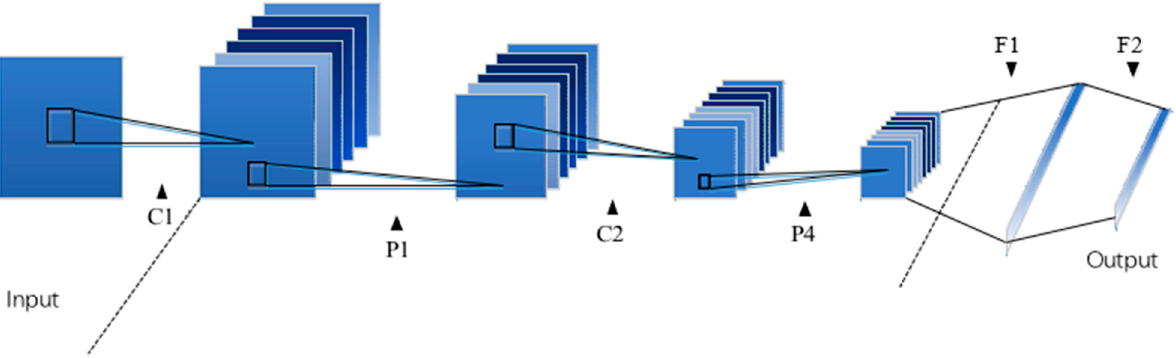
Figure 1. CNN network structure.